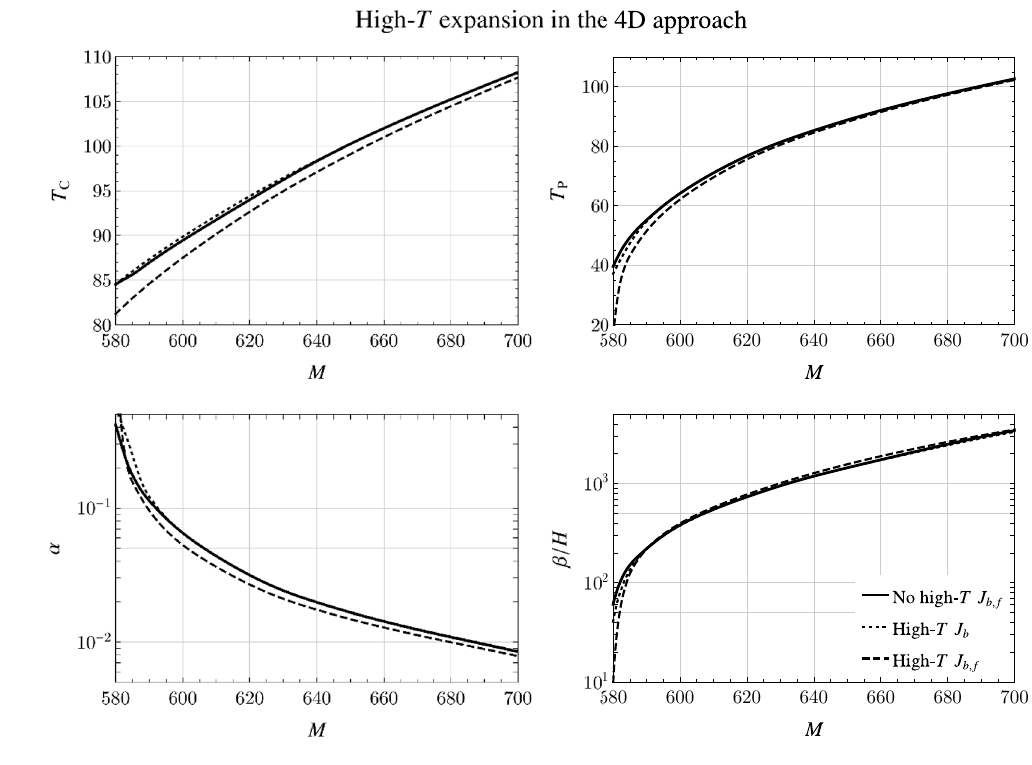
Figure 5 . α , β/H p , each with two lines: (i) full thermal functions at ¯ µ = T (your existing results) and (ii) high- T approximation (up to and including logarithms) for all thermal functions (both fermions and bosons), again at ¯ µ = T . Thermodynamic parameters in the 4d approach, with and without high- T expansion of thermal functions, with a choice ¯ µ = T for the